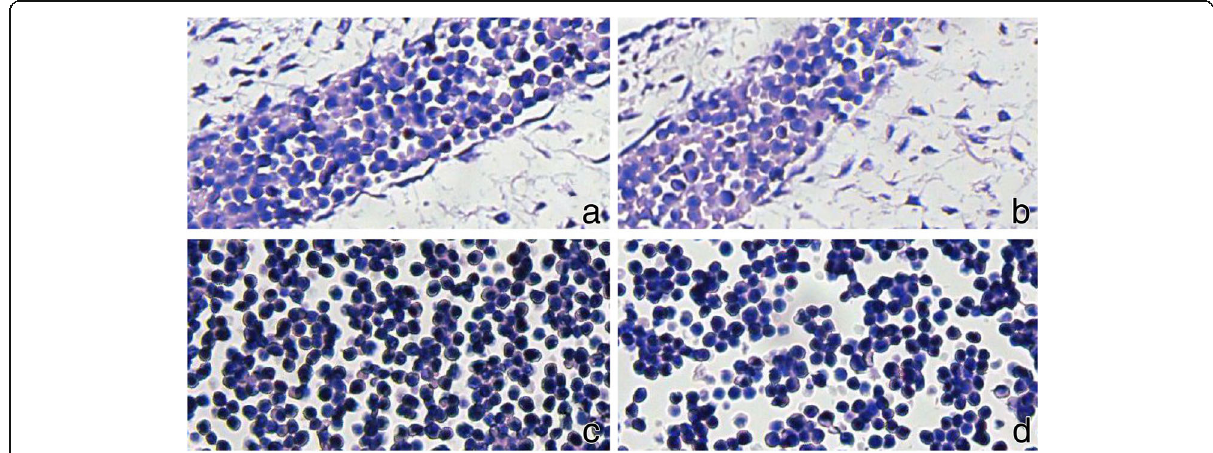
Fig. 3 Immunohistochemical negative staining in early embryonic tissue and its extramedullary hematopoietic tissue. a , b , c , and d show the negative staining of CD3, CD20, CD45Ro, CD79a, respectively, suggesting that these cells are not lymphocytes. 200×